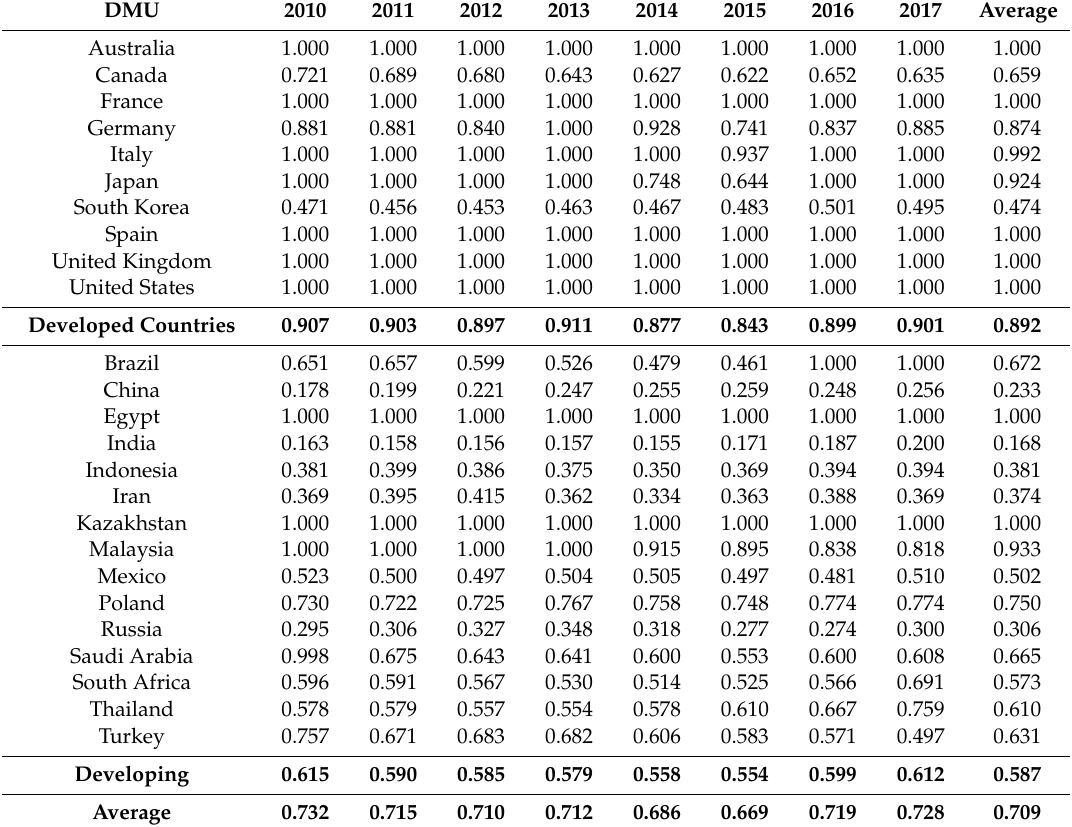
Table 2. Total-factor energy e ffi ciency during